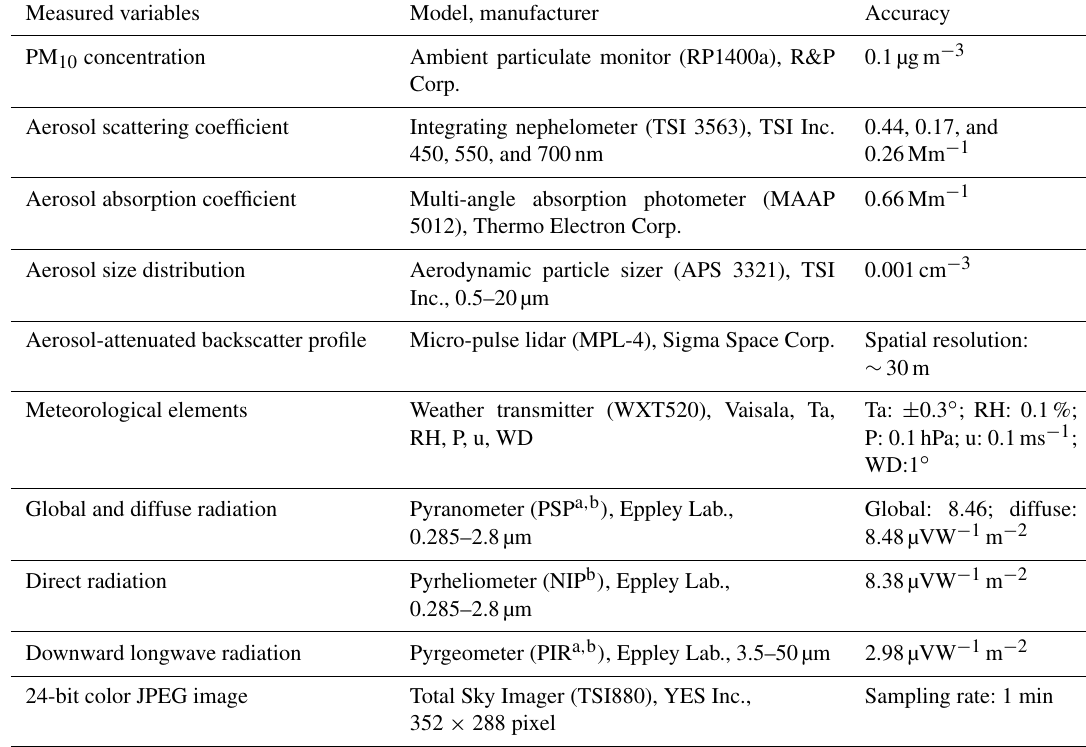
Table 1. The main aerosol observation and other ground-based instruments deployed at Dunhuang farmland during spring of 2012. Measured